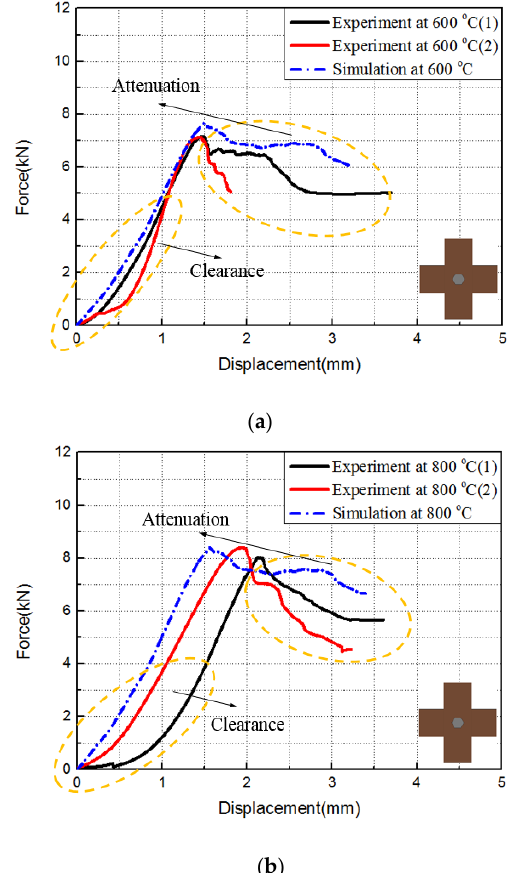
Figure 14. Force–displacement curves of hexagonal bolt joints at ( a ) 600 °C and ( b ) 800 °C .